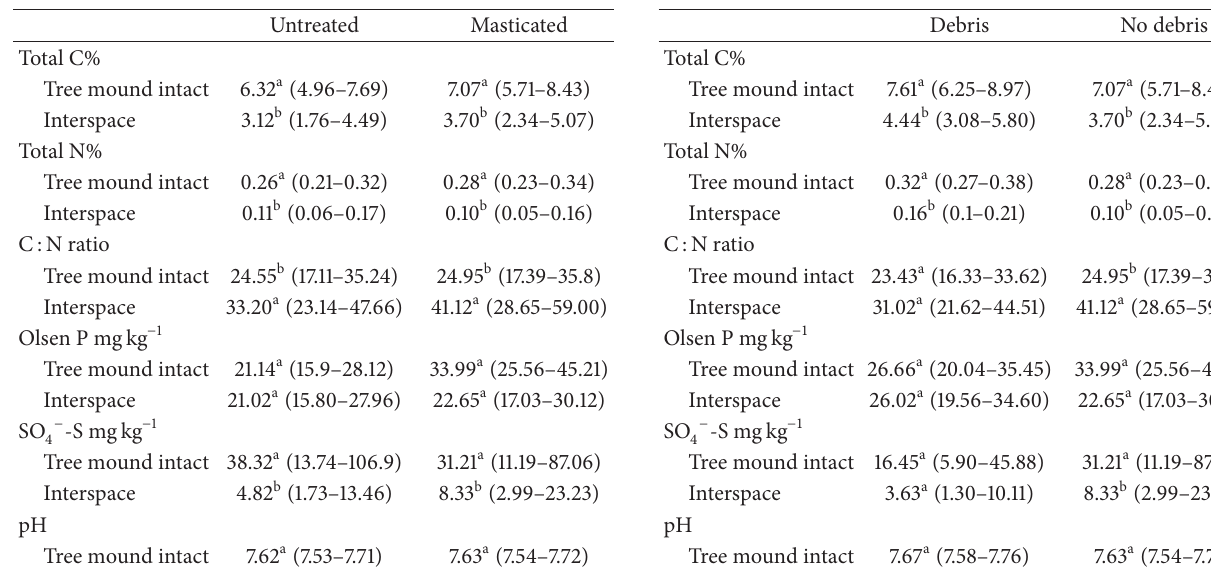
Table4:Masticated-treedebrisandintacttreemoundeffectsonsoil nutrients derived from soil